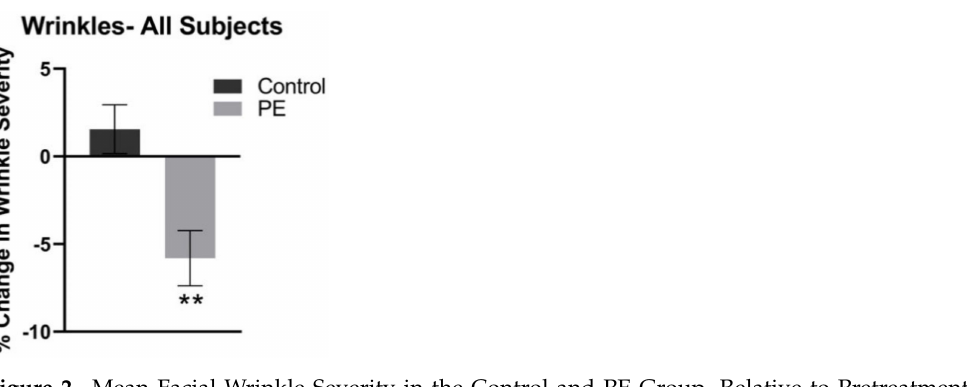
Figure 2. Mean Facial Wrinkle Severity in the Control and PE Group, Relative to Pretreatment Baseline. The facial wrinkle severity was measured through the use of high-resolution imaging analysis of standardized photography. The average facial wrinkle severity decreased by 6.2 ± 1.6 (** p = 0.004) in the PE group and there was no statistical change in the control (placebo) group.